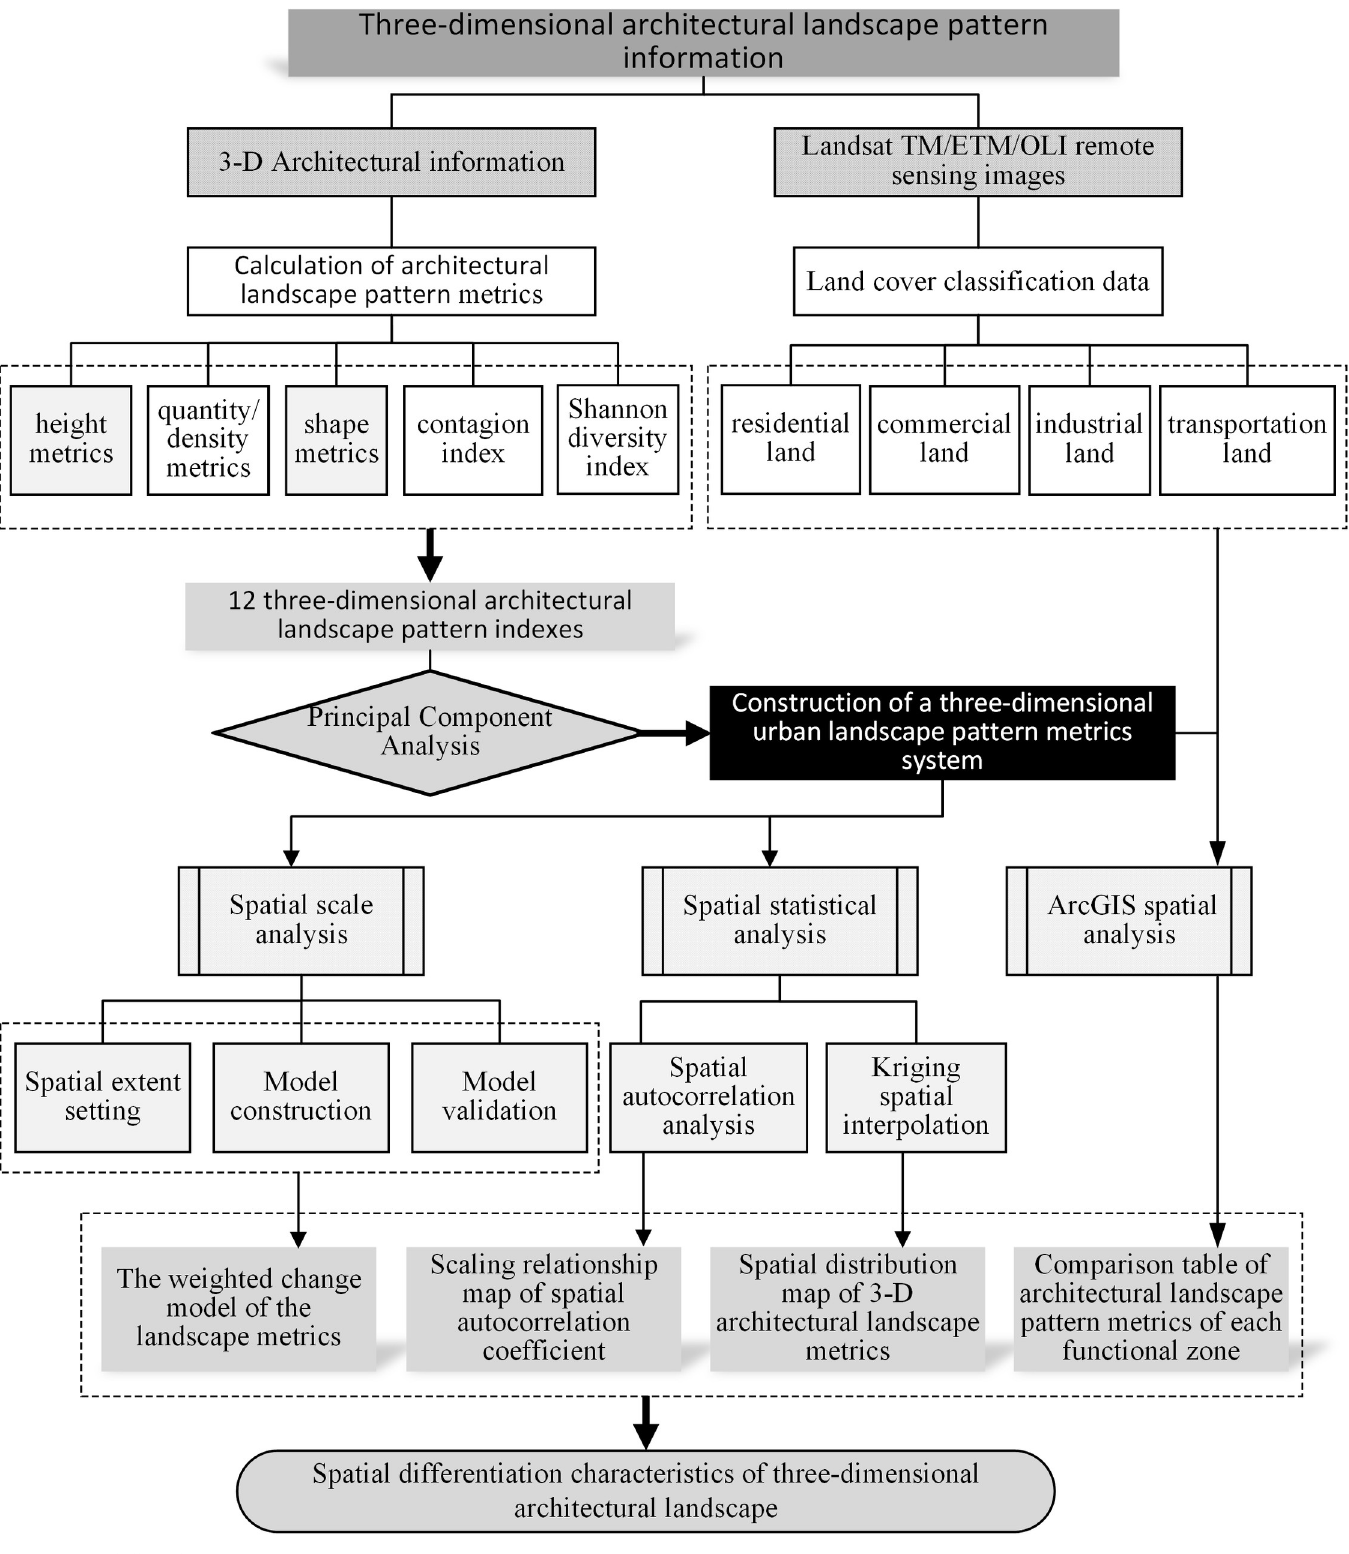
Fig 3. Research flow chart.